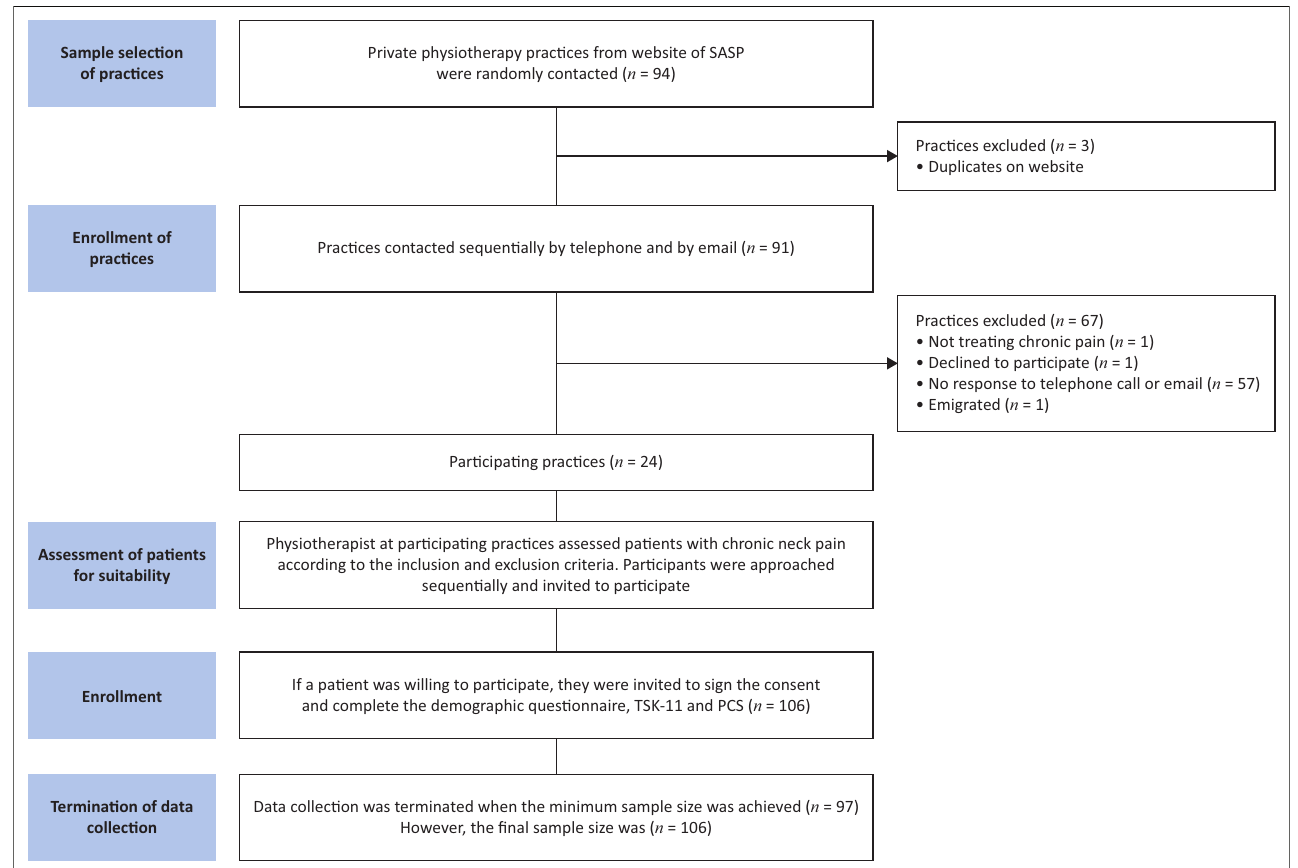
FIGURE 1: Flow diagram showing the sampling procedure of practices and